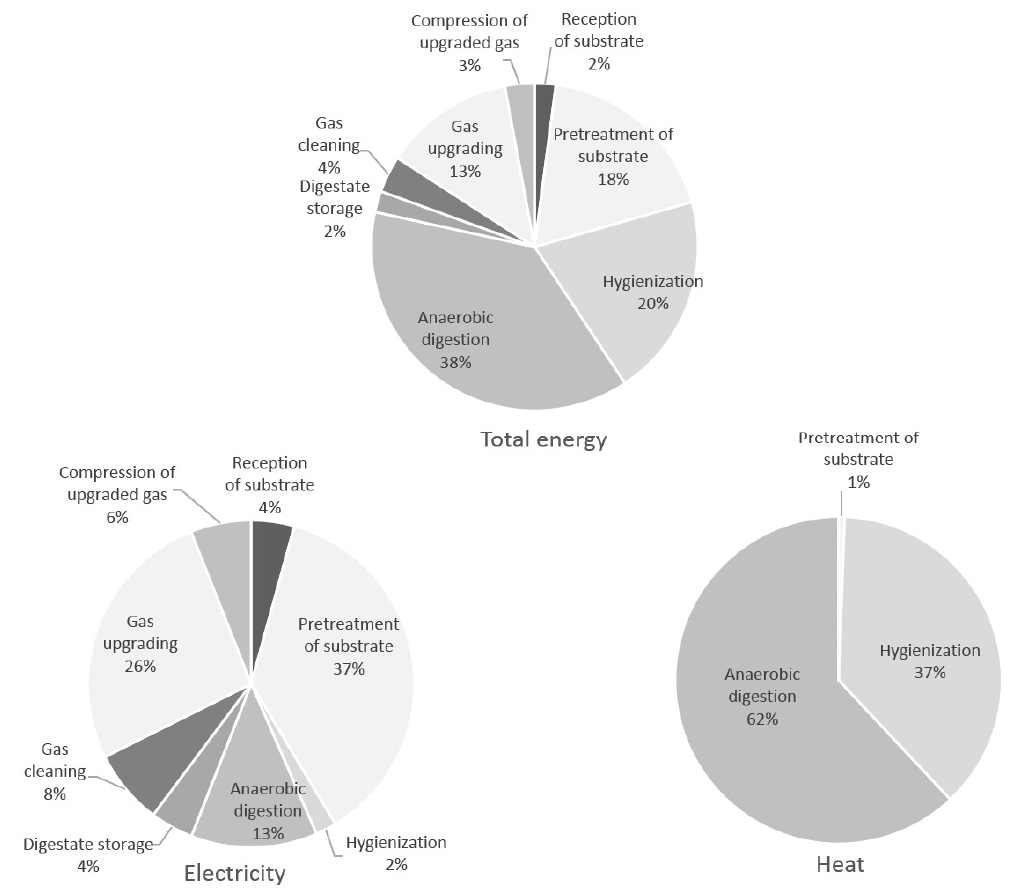
Figure 16. The sub-processes for plant B with system Level 2.